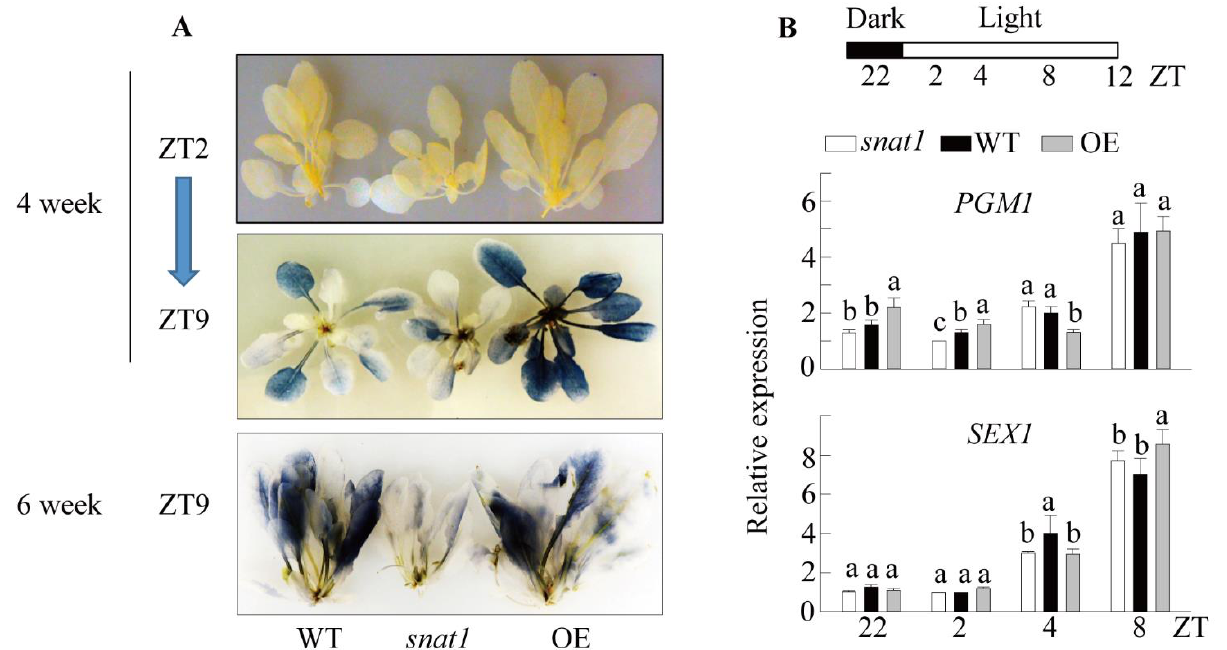
Figure 2. ( A ) Comparison of leaf starch contents. WT (Col-0), snat1 , and SNAT1 OE Arabidopsis lines grown under 50 μmol m -2 s -1 light conditions for four or six weeks were decolorized and stained with iodine solution, washed with water, and photographed. Plants were collected at Zeitgeber time (ZT)2 or ZT9. ( B ) qRT-PCR analysis showing induced expression of starch metabolism-related genes in WT (Col-0), snat1 , and OE Arabidopsis plants. Leaf samples were collected at various ZT intervals. The target transcript levels were normalized to those of the EF1 α endogenous control. ZT, Zeitgeber time; ZT0 represents dawn. Values are means ± standard deviation of three independent experiments. Different letters indicate significant differences (Tukey’s post hoc HSD test; p < 0.05).